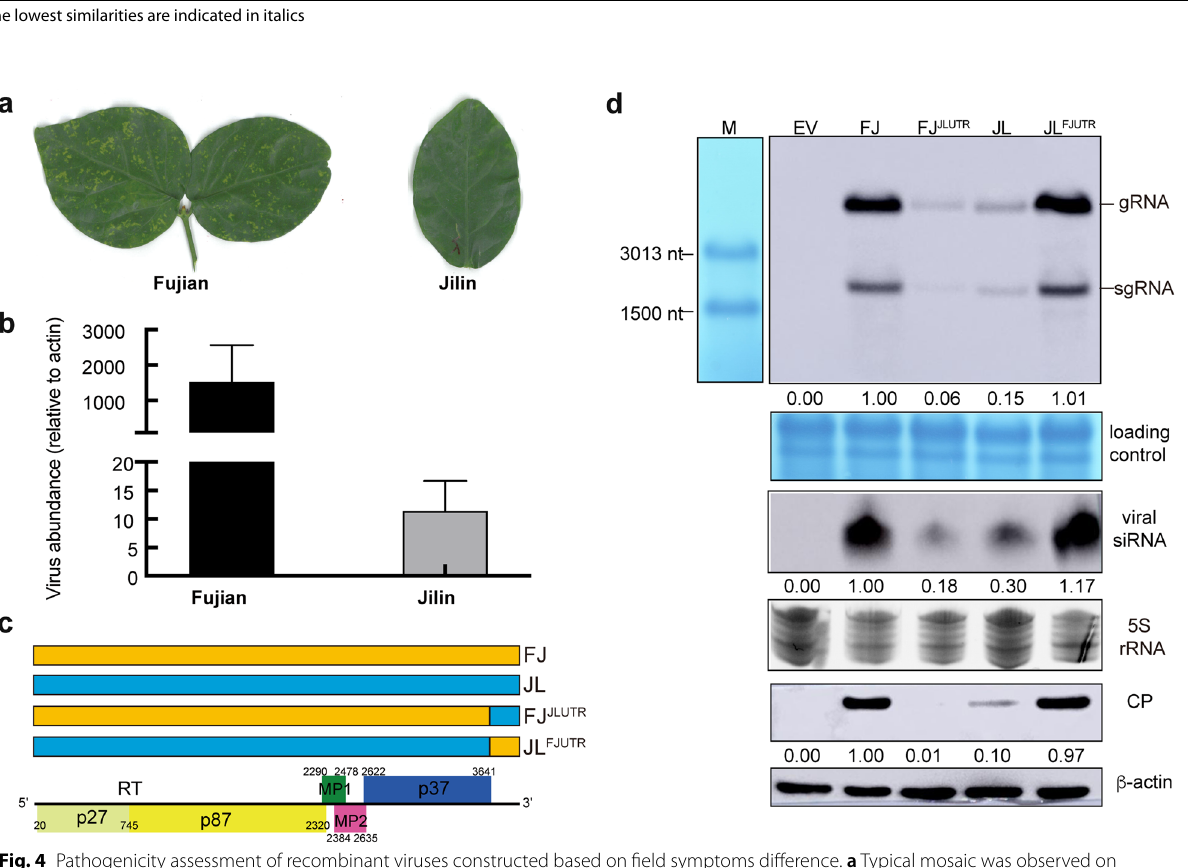
The lowest similarities are indicated in italics